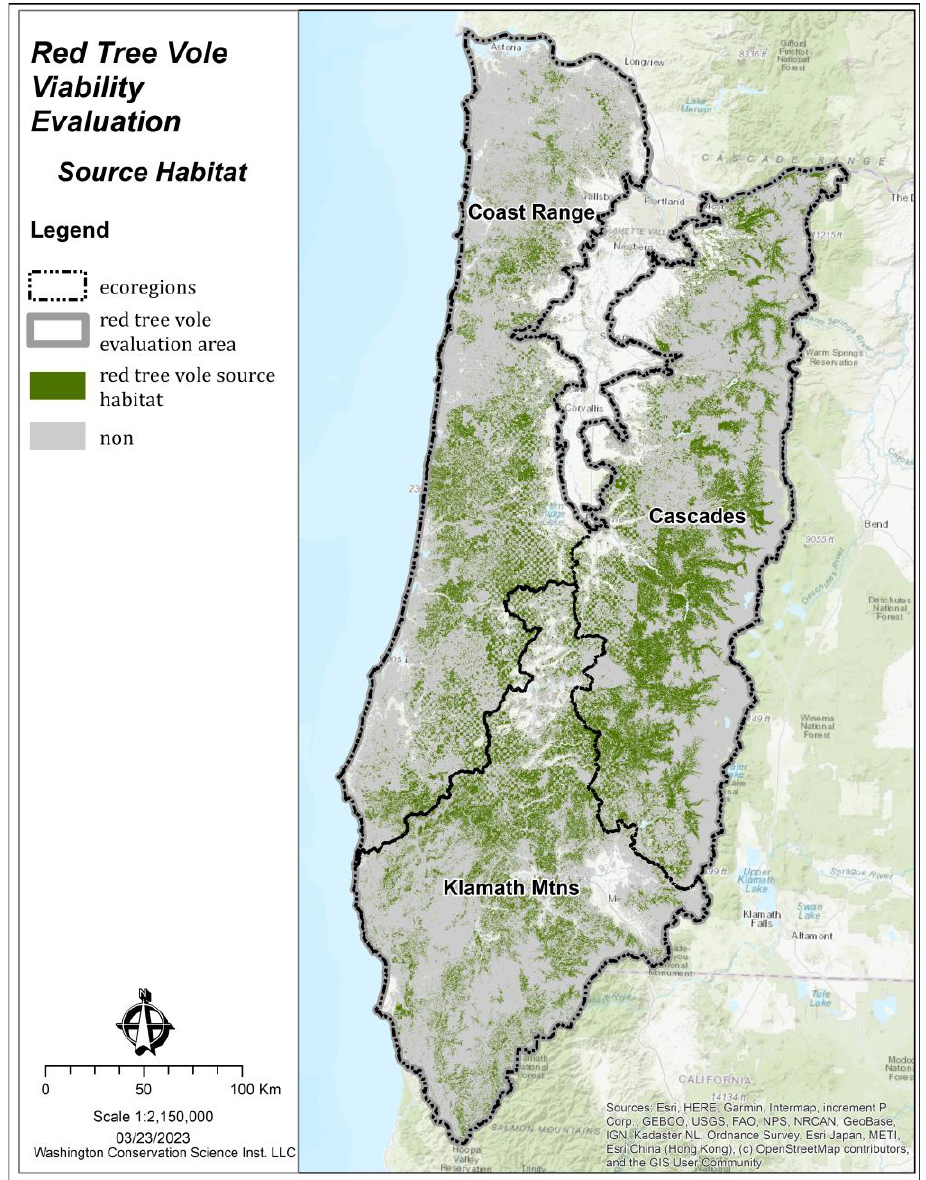
Figure 4. Source habitat for red tree voles ( Arborimus longicaudus ) by ecoregion within the evaluation area in Oregon and California, USA.